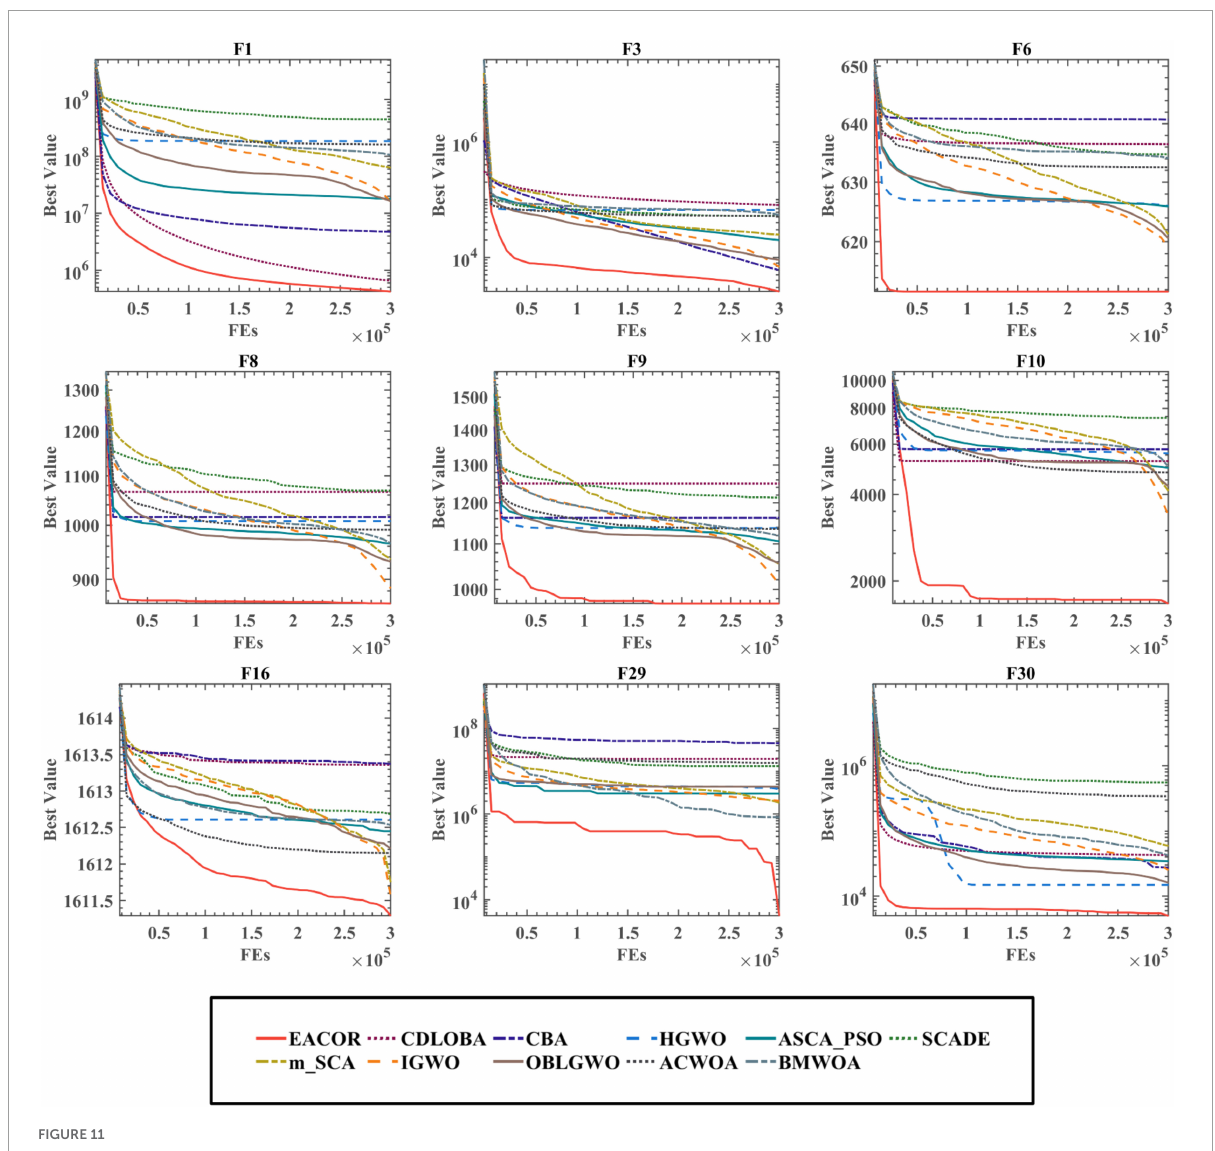
FIGURE11 Convergence curves of EACOR with ten